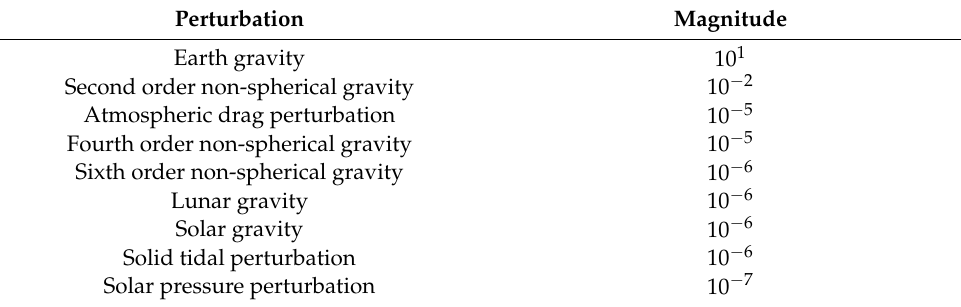
Table 1. Magnitude of perturbed acceleration of LEO satellite.